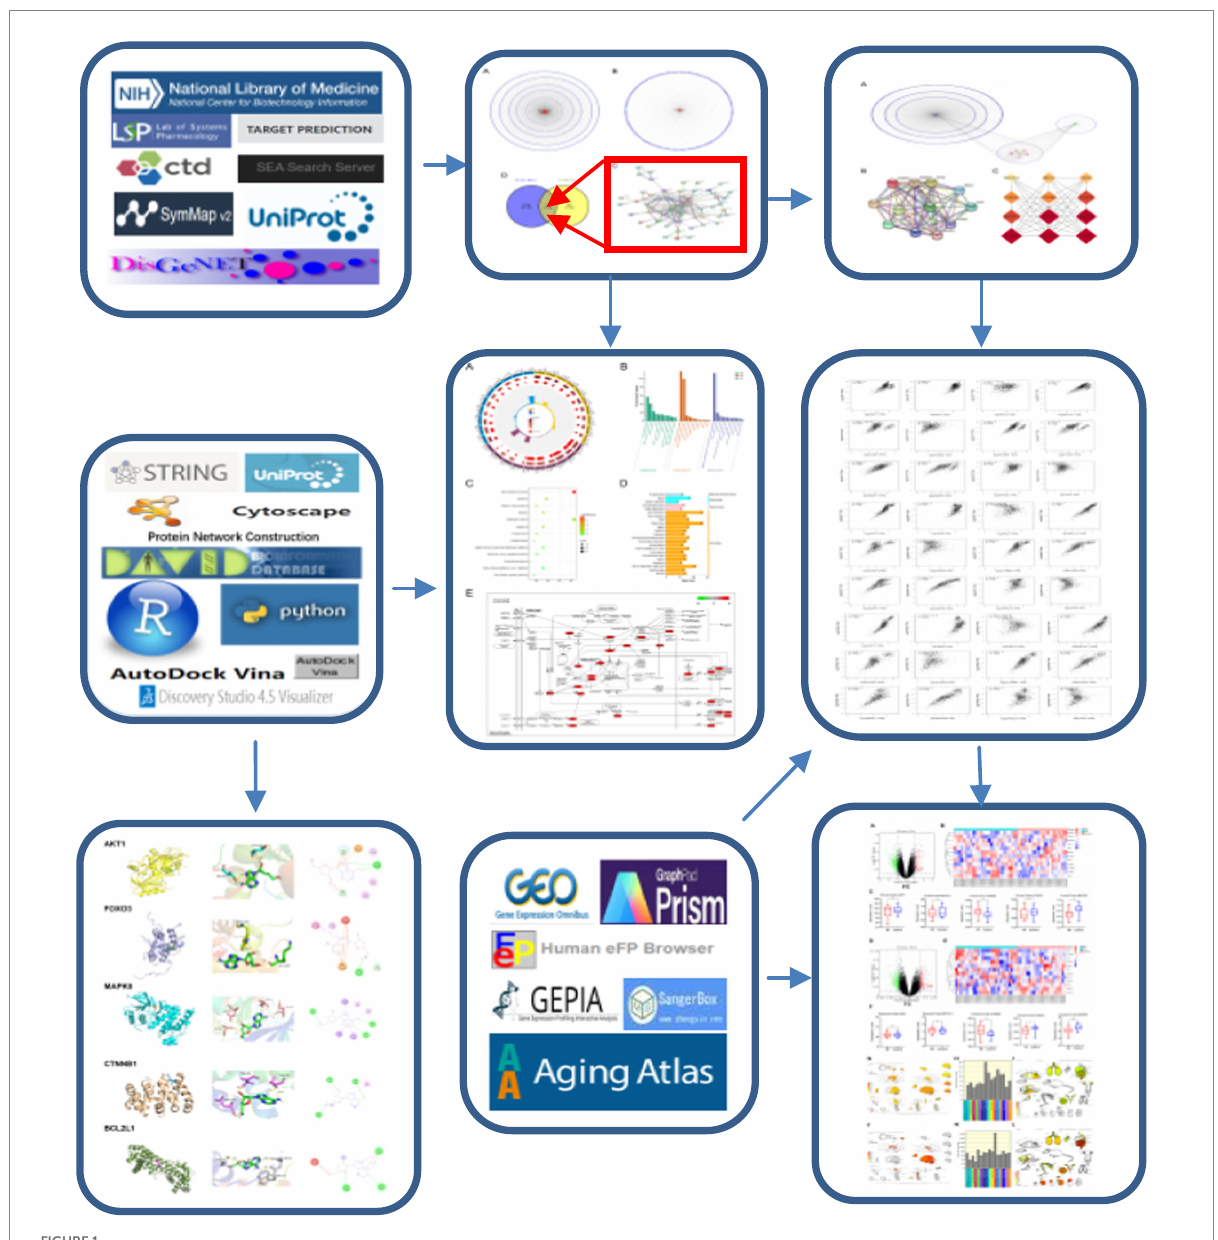
FIGURE 1 Network Pharmacology Workflow of Cordycepin in the treatment of Alzheimer’s